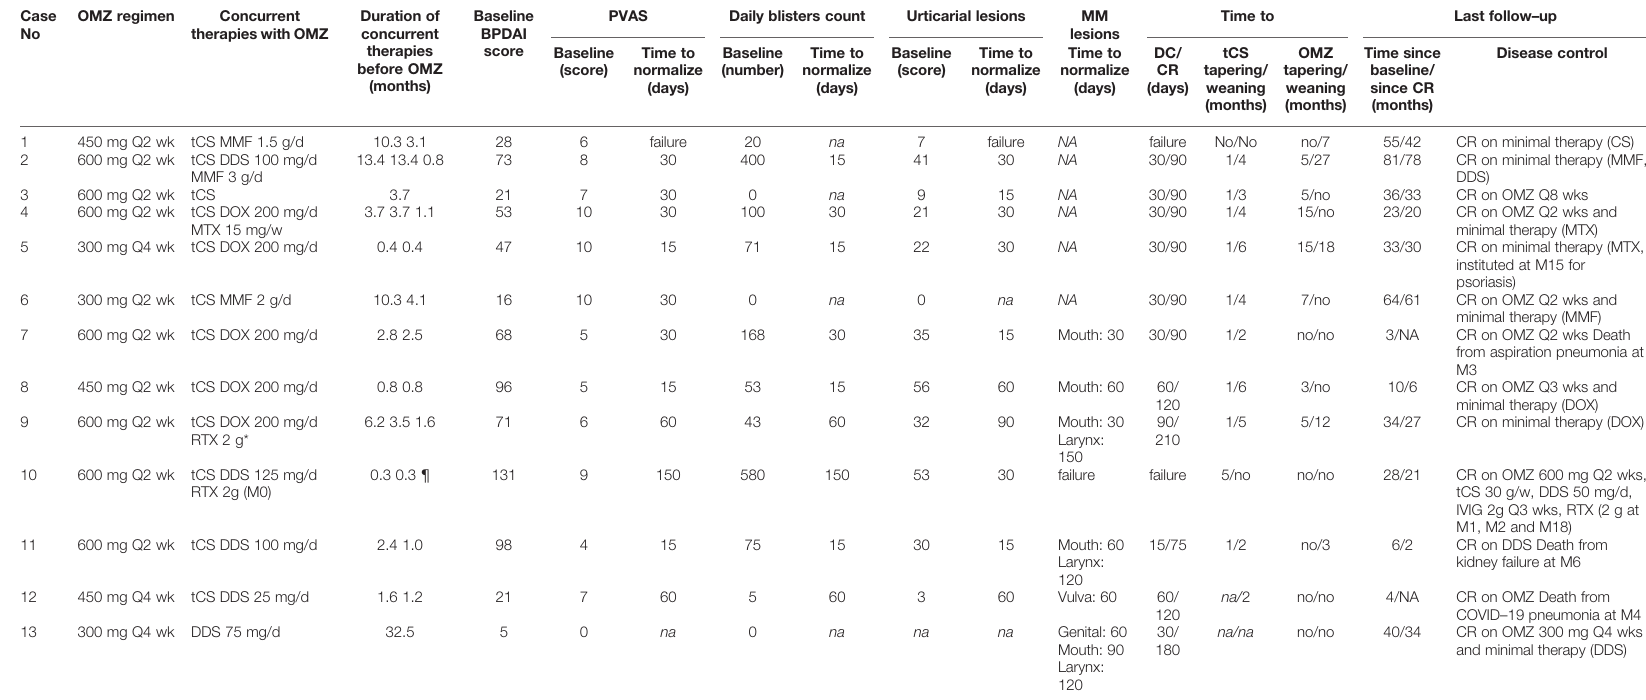
TABLE 2 | Outcomes of OMZ therapy. Case